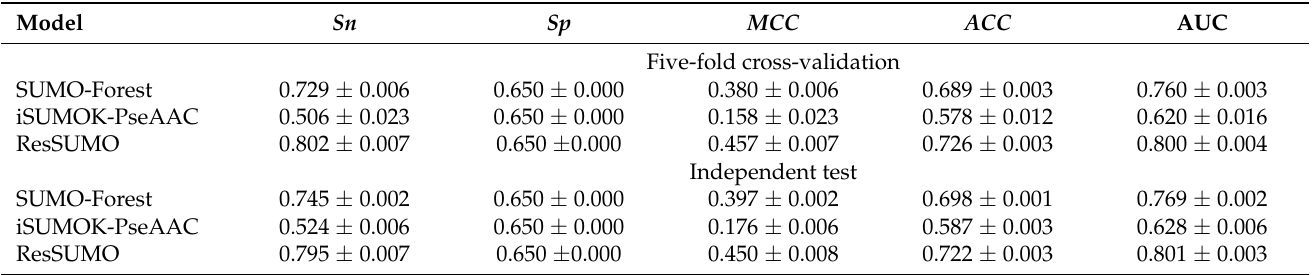
Figure 5. The AUC values of ResSUMO, the reproduced SUMO-Forest, and iSUMOK-PseAAC in five-fold cross-validation ( A ) and performance comparison ( B ). Table 2. Comparison of performance between ResSUMO and the reported models based on five-fold cross-validation and independent